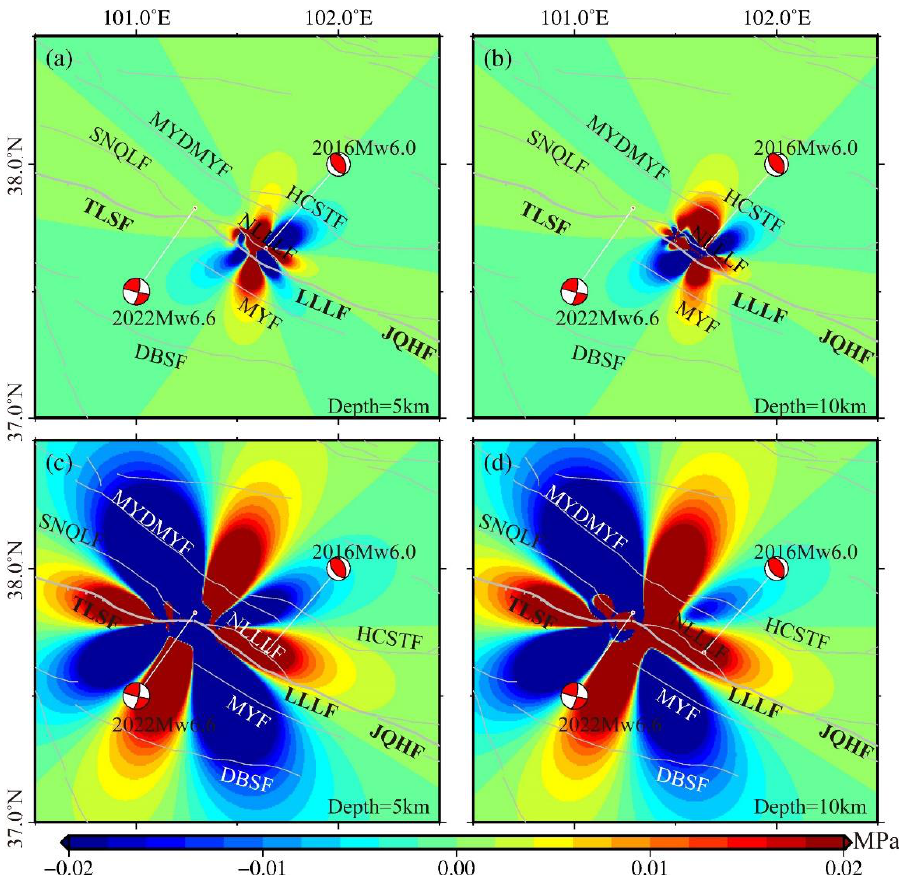
Figure 9. Distribution of ΔCFS caused by the 2016 and 2022 Menyuan earthquakes at depths of 5 km and 10 km. ( a , b ) ΔCFS caused by the 2016 earthquake, ( c , d ) ΔCFS caused by the 2022 earthquake. HSCTF: the Huangcheng-Shuangta fault; MYDMYF: the Minyue-Damaying fault; SNQLF: the Sunan-Qilian fault; NLLLF: the northern Lenglongling fault; TLSF: the Tuolaishan fault; LLLF: the Lenglongling fault; JQHF: the Jinqianghe fault; MYF: the Menyuan fault; DBSF: the Dabanshan fault. Four significant stress-loading areas imposed by the 2022 earthquake are identified.